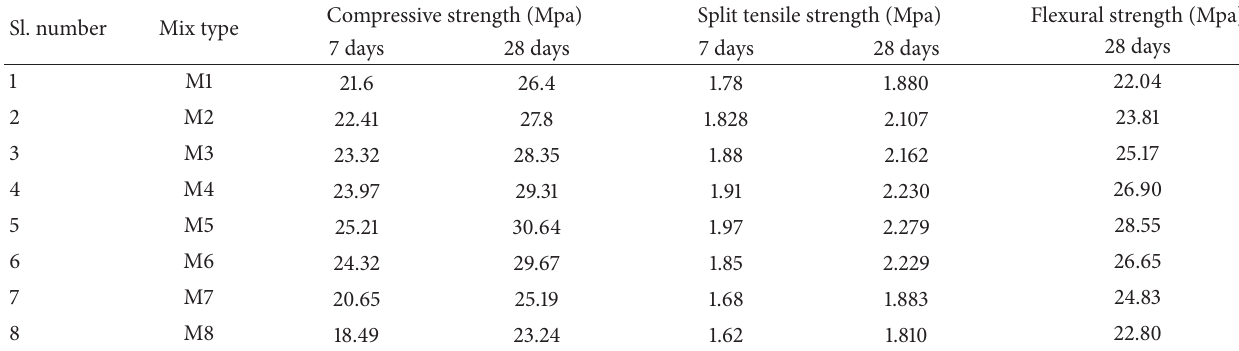
Table 3: Compressive strength split tensile strength and flexural strength for mixing concrete. Sl.